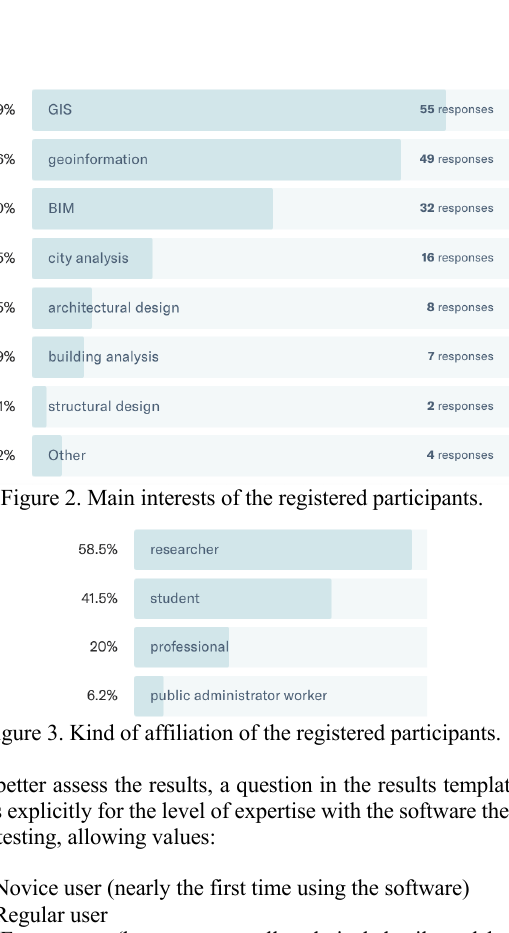
Figure 6. Tools participants declared to test in comparison with the approximated number of solutions as assessed and suggested by the benchmark organisers (different versions are not counted as different